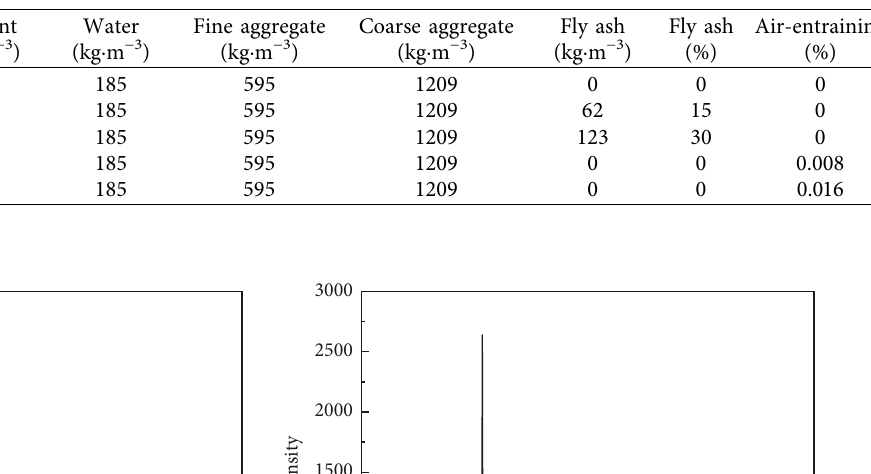
Table 2: Mix proportions of concrete.